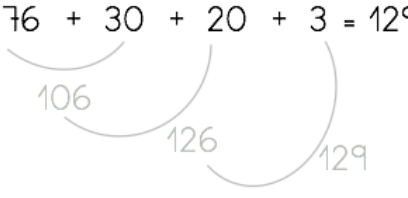
Figure 16. Route followed for the resolution.